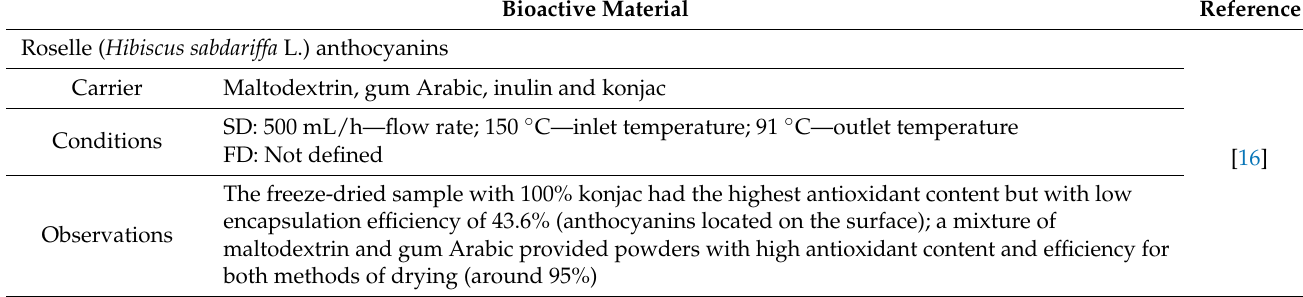
Table 3. Studies of spray-drying (SD) and freeze-drying (FD) applications for encapsulation of polyphenols from different